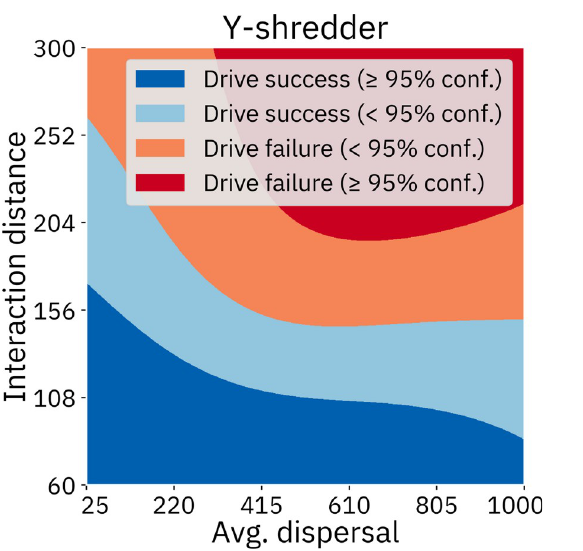
Fig 13. Y-shredder with varying interaction distance and average dispersal. Drive fitness and efficiency were both fixed at 99%. Other parameters were fixed at default values.